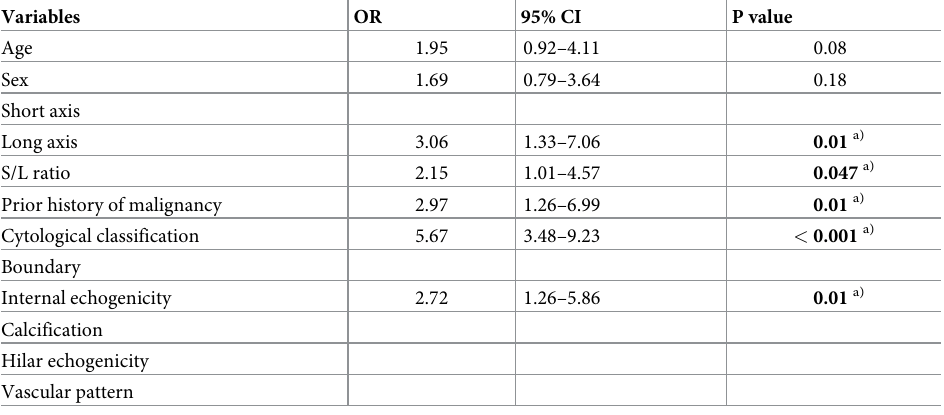
Table 3. Multivariate analyses performed by using a stepwise logistic regression model to identify the risk factors for malignant results in patients who had neck LNs with indeterminate